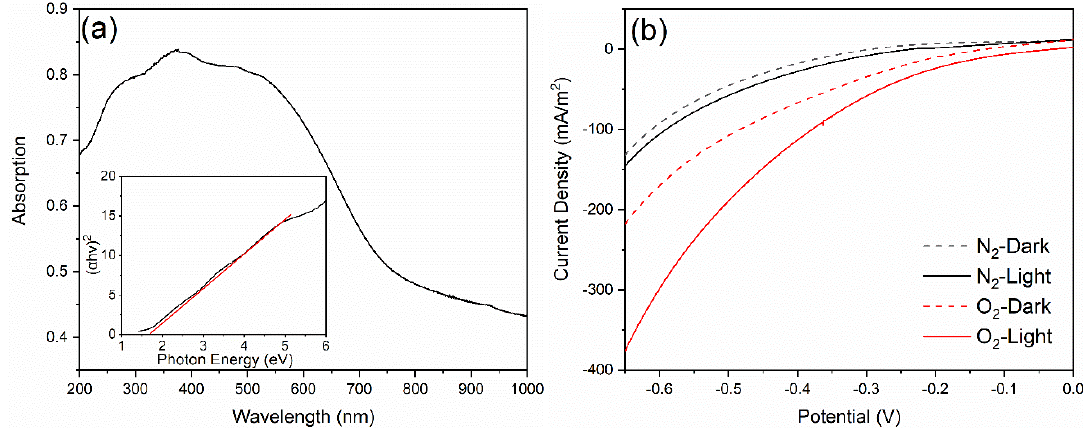
Figure 4. UV-Vis of natural wolframite ( a ) and linear sweep voltammetry (LSV) curves under dark/light conditions in O 2 /N 2 ( b ).